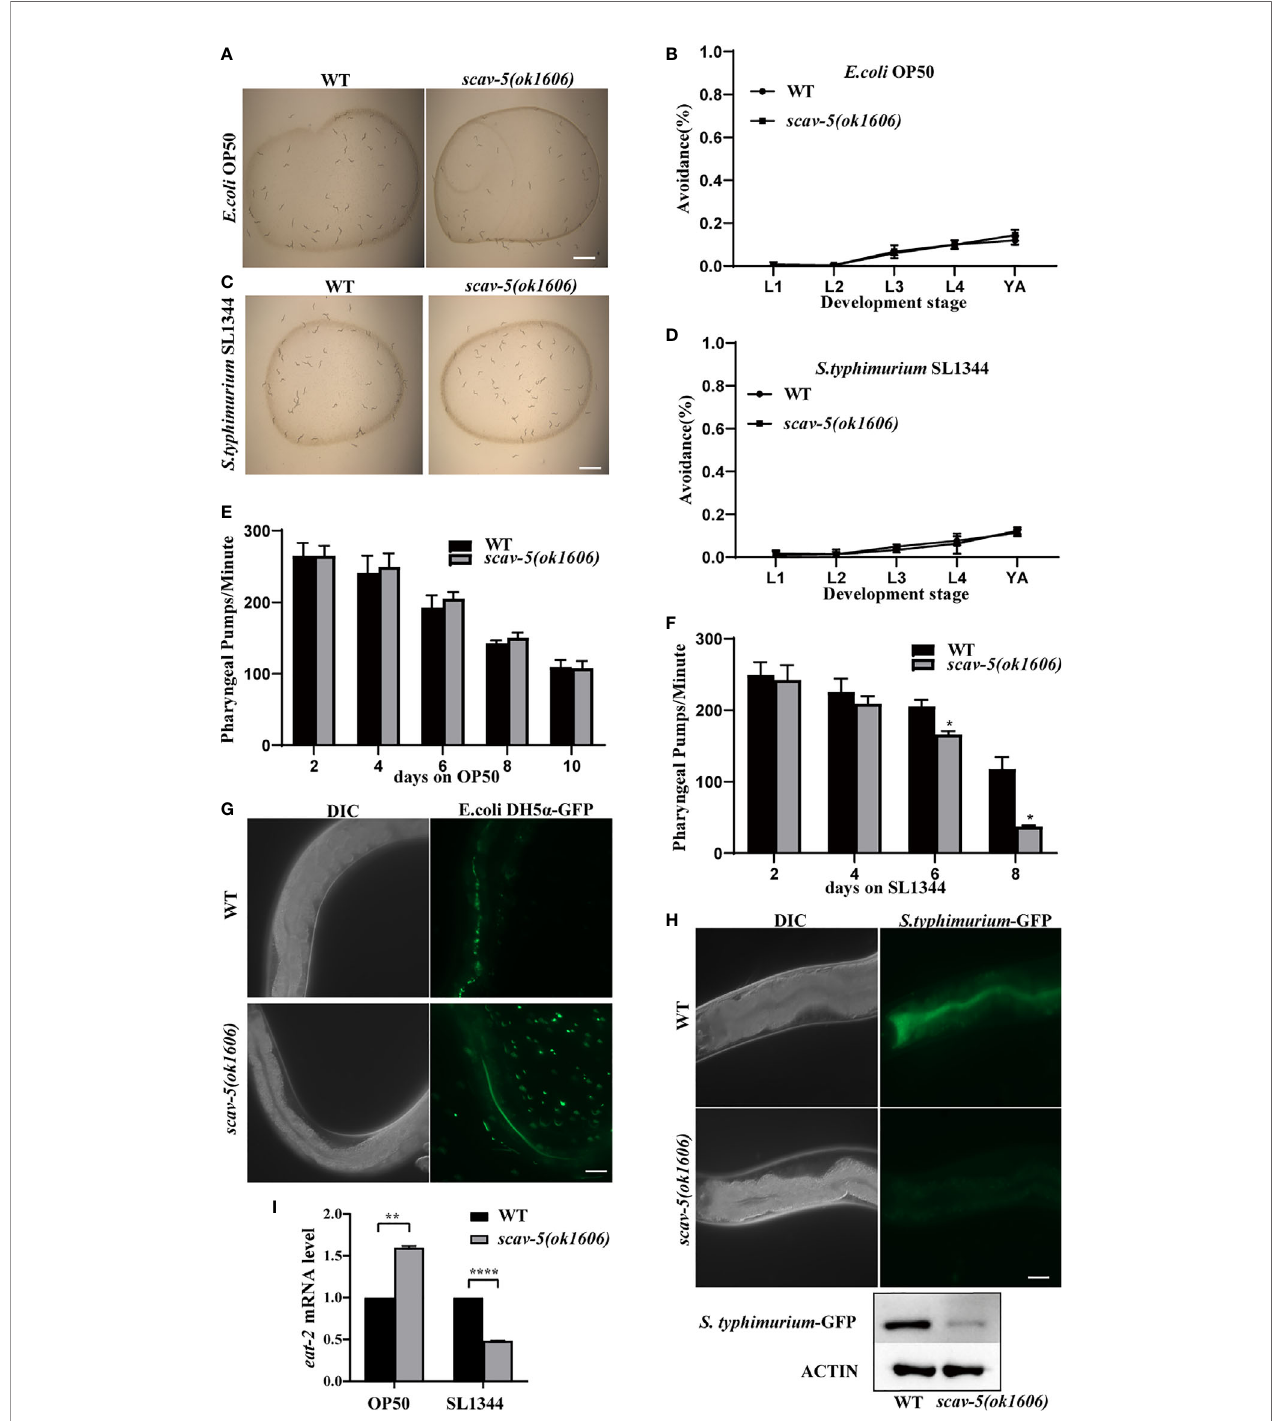
FIGURE 3 | scav-5 mutants display dietary restriction when cultured on S. typhimurium SL1344. (A, C) Bright fi eld photographs of wild type and scav-5(ok1606) mutant cultured on E. coli OP50 (A) and S. typhimurium SL1344 (B) both have no avoidance behavior at L4 stage. Scale bar=100 m m. (B, D) Quanti fi cation of avoidance rate of scav-5(ok1606) mutants cultured on E. coli OP50 (B) and S. typhimurium SL1344 (D) from L1 to young adult stage. (E, F) Pharyngeal pumps per min of wild type and scav-5(ok1606) mutants fed with E. coli OP50 (E) and S. typhimurium SL1344 (F) . (G, H) The DIC and GFP fl uorescence image of partial intestine in wild type and scav-5(ok1606) mutant cultured on E. coli OP50 (G) and S. typhimurium SL1344 (H) 48 h after L4 stage. Scale bar=20 m m. (I) qRT-PCR analysis of transcription level of DR gene eat-2 in wild-type and scav-5(ok1606) animals cultured on E. coli OP50 or S. typhimurium